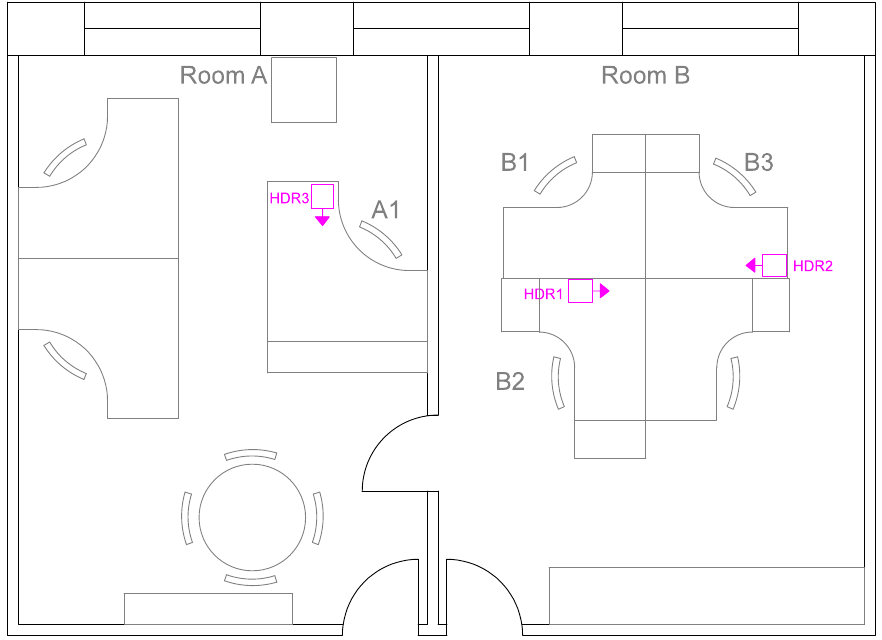
Figure 2. Room layout showing desks, participant seating positions (A1, B1, B2 and B3) and luminance cameras (HDR1–HDR3; HDR, high dynamic